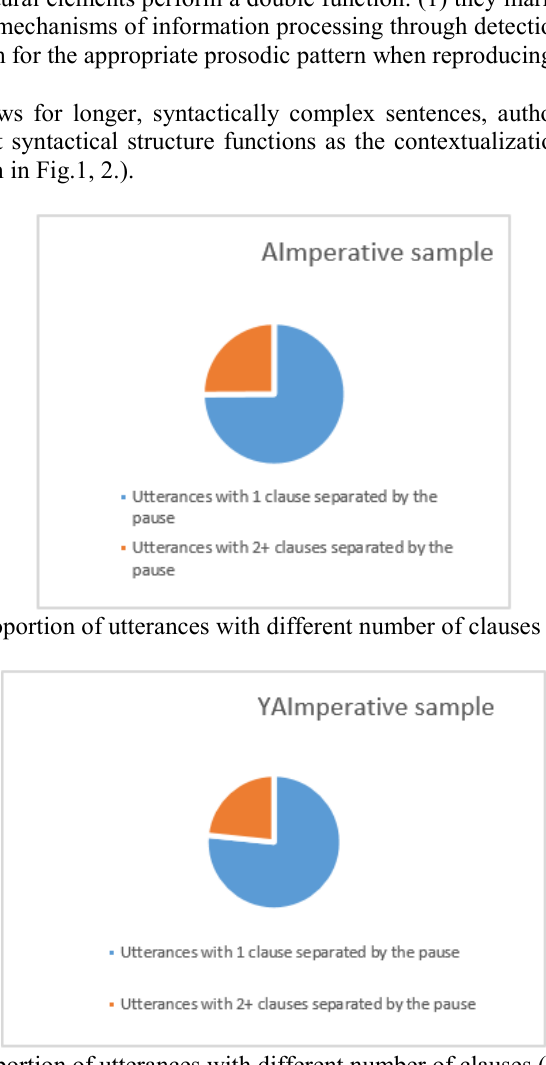
Figure 2 – Proportion of utterances with different number of clauses